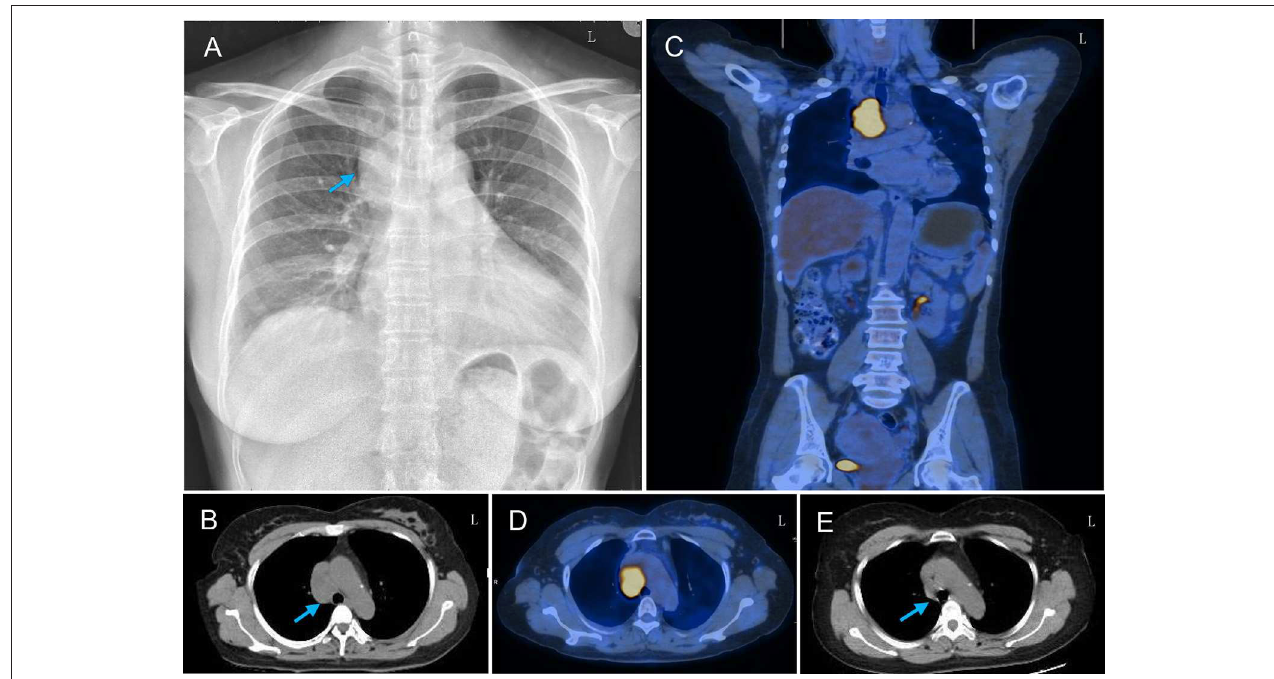
FIGURE 2 | Thoracic radiograph and PET-CT findings of the patient. (A) Chest X-ray showed a round soft tissue mass (arrow) in the upper-mid mediastinum and infiltrating right lung field. (B) Thoracic CT showed a round soft tissue mass (arrow) located in the upper-mid mediastinum before the arteroae aorta. (C,D) PET-CT scan showed increased uptake of fluorodeoxyglucose signal in this mass axial and coronal plane images. (E) Repeated thorax CT showed the resolution of the mediastinal mass after